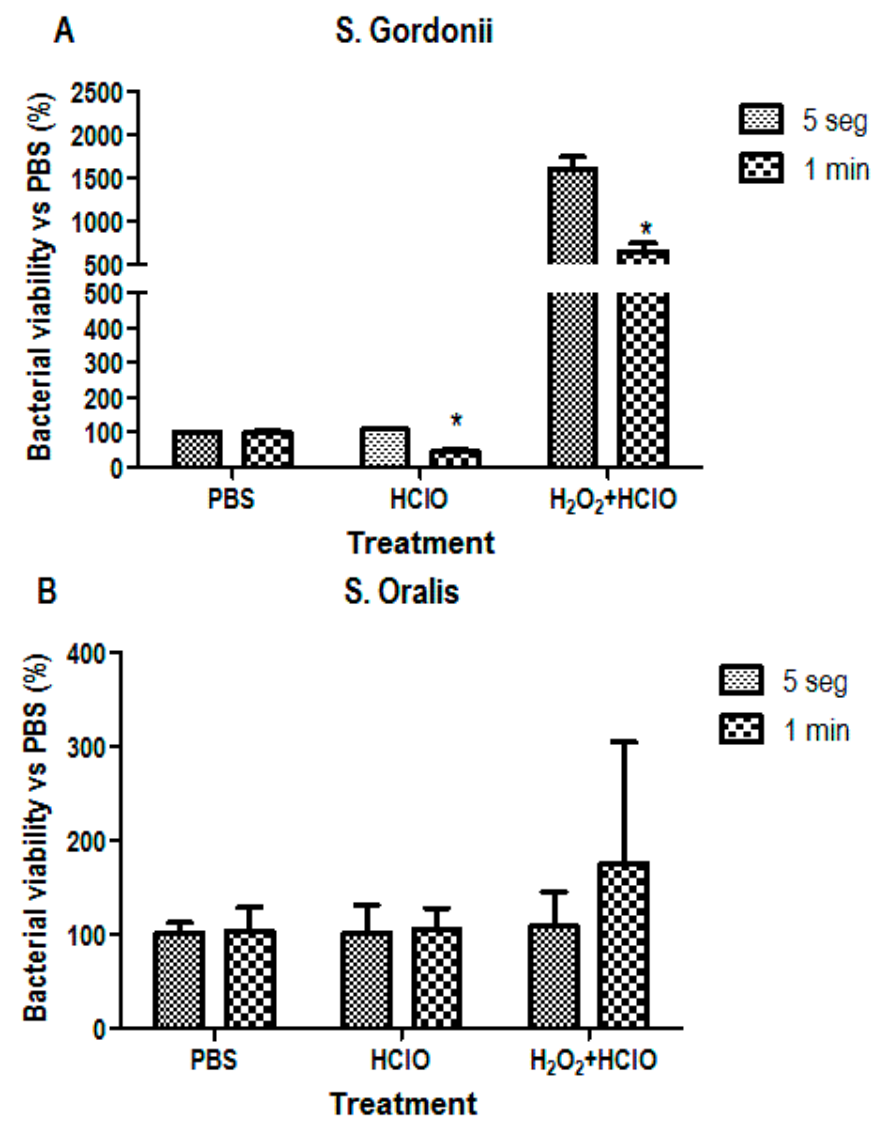
Figure 6. Bacterial viability analysis. Cultures performed on Streptococcus gordonii ( A ) and Strepto- coccus oralis ( B ) by incubating the discs in the treatment solution for 5 s and for 1 min. The treatments used were hypochlorous acid (HClO) and hydrogen peroxide (H 2 O 2 ) + HClO, using a PBS treatment as control. * p < 0.05.